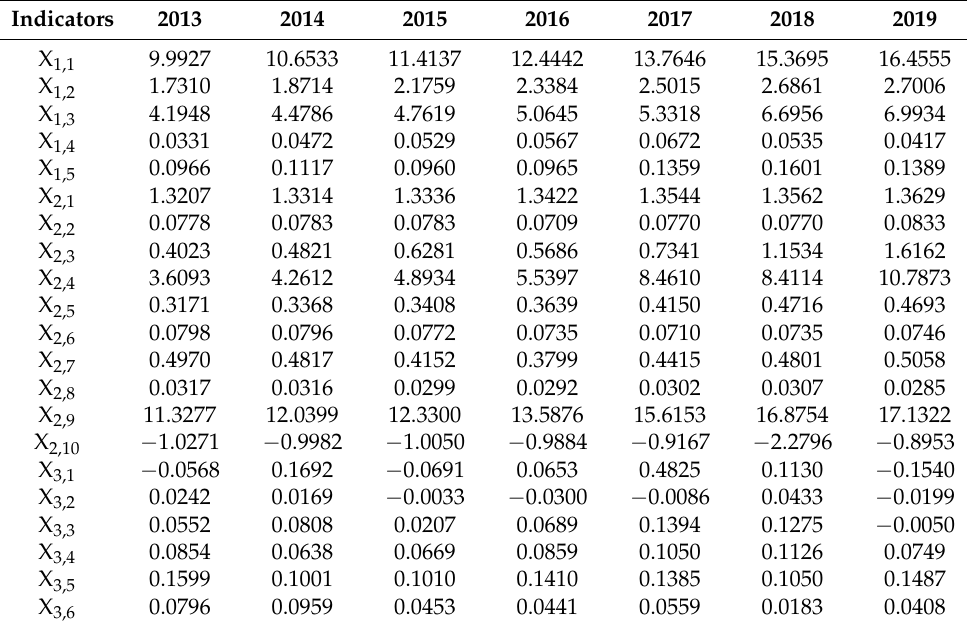
Table 5. Raw data of each indicator in Beijing.